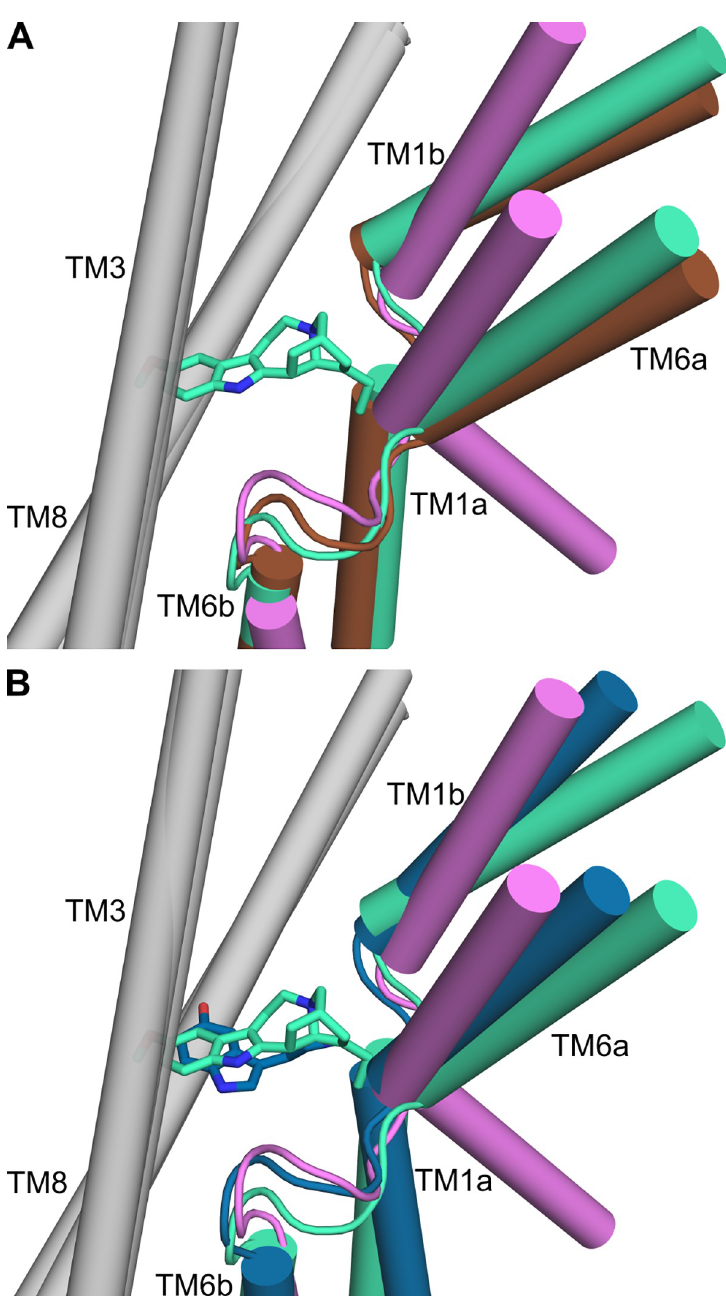
Fig 11. Comparison of hSERT conformations: shown are the ibogaine-bound cryo-EM structures in outward-open (brown), outward-occluded (green), and inward-open (pink) states, alongside the outward-occluded, 5HT-bound model (blue). TM1b and TM6a are shown in color, whereas TM3 and TM8 of the hash region are in grey. Ligands bound in the orthosteric binding site are ibogaine (green sticks) in outward-occluded 6DZV, and 5HT in the outward- occluded model (blue sticks). A) Comparison of the cryo-EM structures in outward-open (6DZY), outward-occluded (6DZV), and inward-open (6DZZ) states. B) The outward-occluded model presented in this study (blue, from the final frame of MD replica 2), bound to 5HT, has bundle helix positions midway between the outward-occluded and inward- open, ibogaine-bound cryo-EM structures. All structures in both panels A and B were aligned using the backbone atoms in TM3, TM4, TM8, and TM9, i.e. the hash